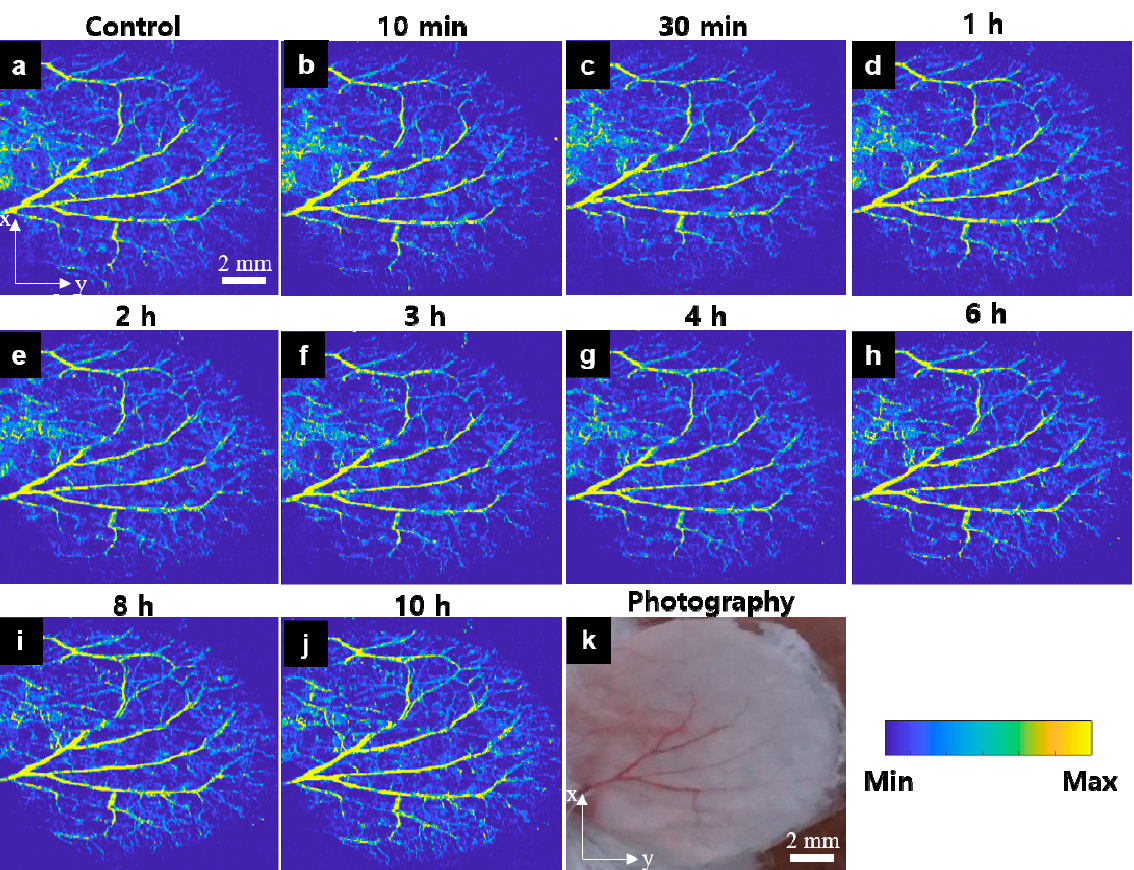
Figure 4. In vivo OR-PAM MAP images for the peripheral vasculatures of the mouse ear after bortezomib solution injection (Movie 2). ( a ) OR-PAM MAP image before bortezomib injection, ( b – j ) OR-PAM MAP images after bortezomib solution injection within 10 h, and ( k ) Photograph of the corresponding mouse ear.